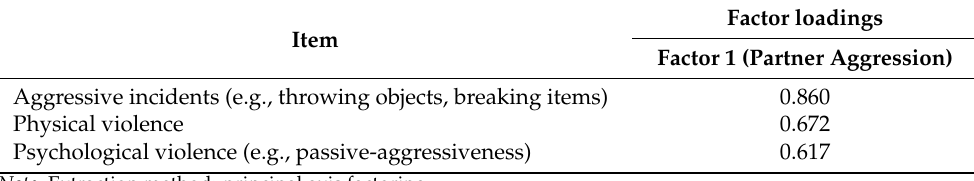
Table 4. Factor analysis of types of partner